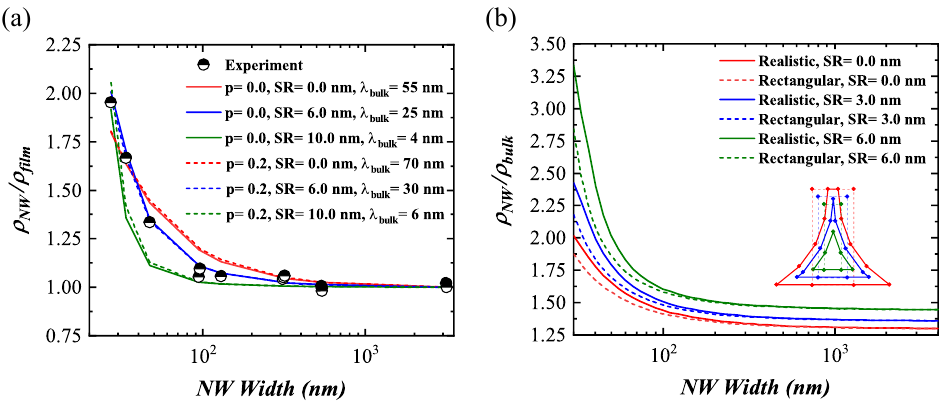
Figure 5. ( a ) Best fit of normalized NW resistivity for different pairs of p and SR . For each pair, λ bulk was determined by a least-mean-squares fit. ( b ) Normalized NW resistivity for different thicknesses of the scattering region SR and for two different shapes of the cross-section: the realistic shape and a rectangular approximation. The inset displays the corresponding cross-sectional shape for the smallest